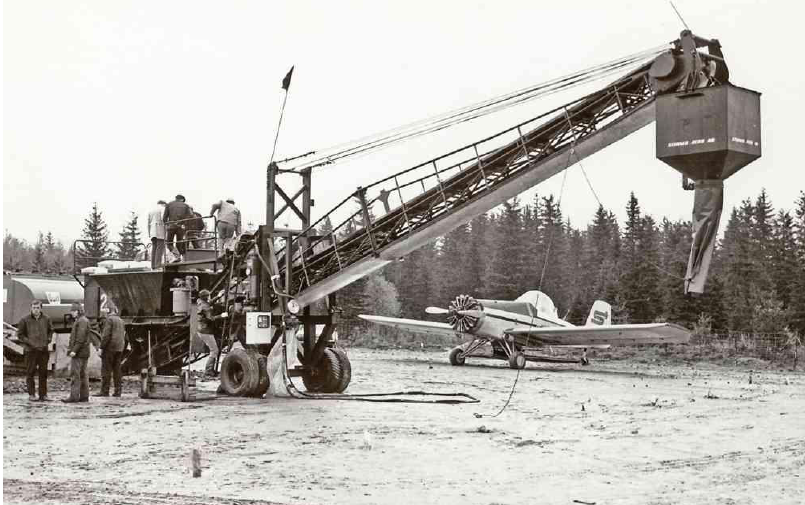
Figure 3. Airfield and fertilizer depot in a Swedish forest. Recommendations on how to store fertilizers to prevent poisoning of animals were announced in the 1960s. The spreading of fertilizers by aircraft was common until the early 1980s when it was succeeded by the helicopter. During the 1990s spreading by tractor became the most common practice  29  . Source: Supra AB‘s Archive, Skånes Näringslivsarkiv, Helsingborg, Sweden. Photographer